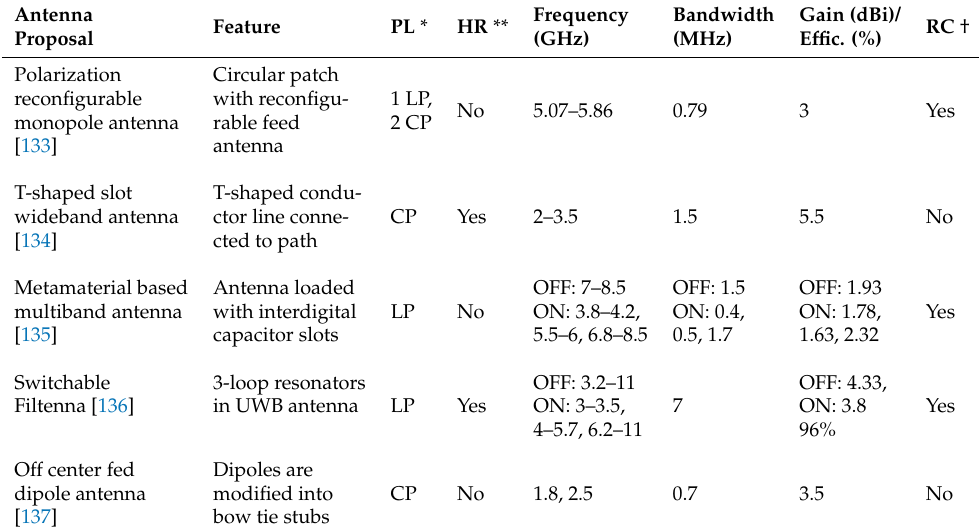
Table 6. A chronologically ordered summary of indicative harmonic rejection and re-configurable antennas for RF power